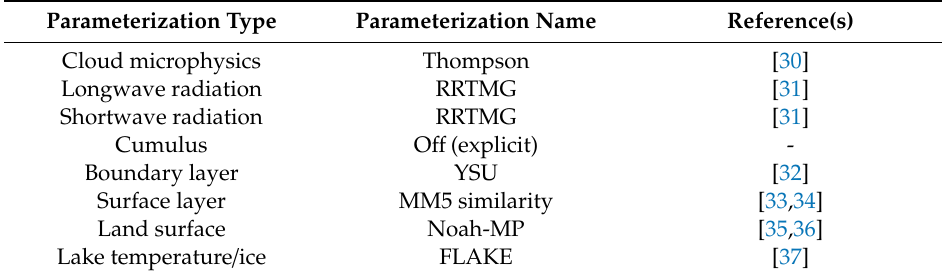
Figure 1. Computational domain for the WRF simulation. Table 1. List of physics parameterizations for the WRF simulation. Additional settings used within the Noah-MP land surface model can be found in Table 1 of [26].